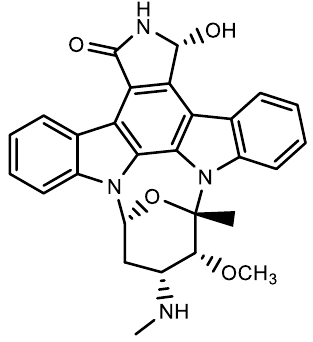
Figure 5. Structure of 7-hydroxystaurosporine ( 9